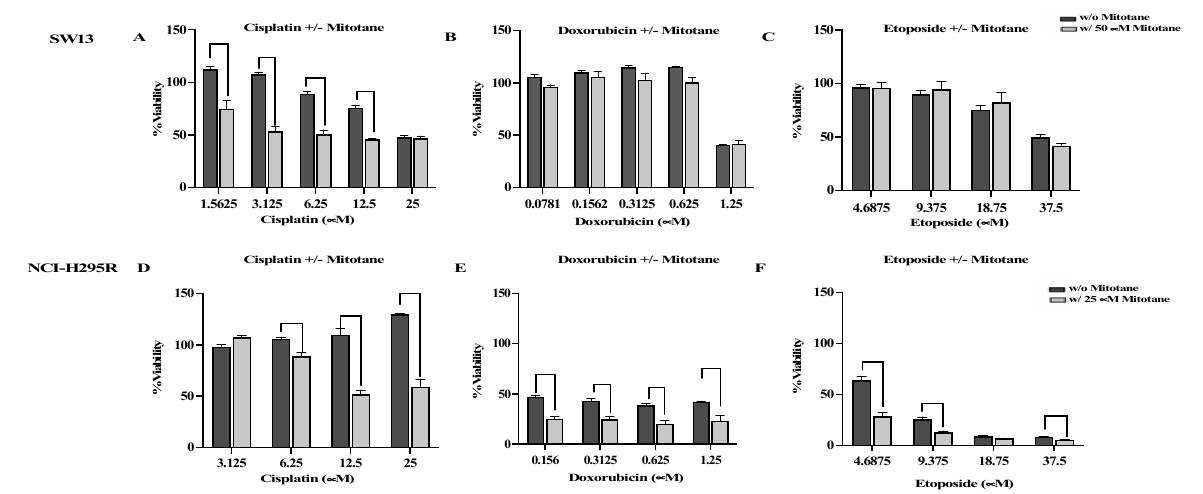
Figure 2. SW13 and NCI-H295R cells were treated with chemotherapeutic drugs (etoposide ( C , F ), doxorubicin ( B , E ), or cisplatin ( A , D )) with or without mitotane and the viability was determined by MTS assay. Percentage viability of cells with respect to untreated control was calculated. Experiments were repeated twice in triplicate, and the values are presented as mean ± standard deviation.